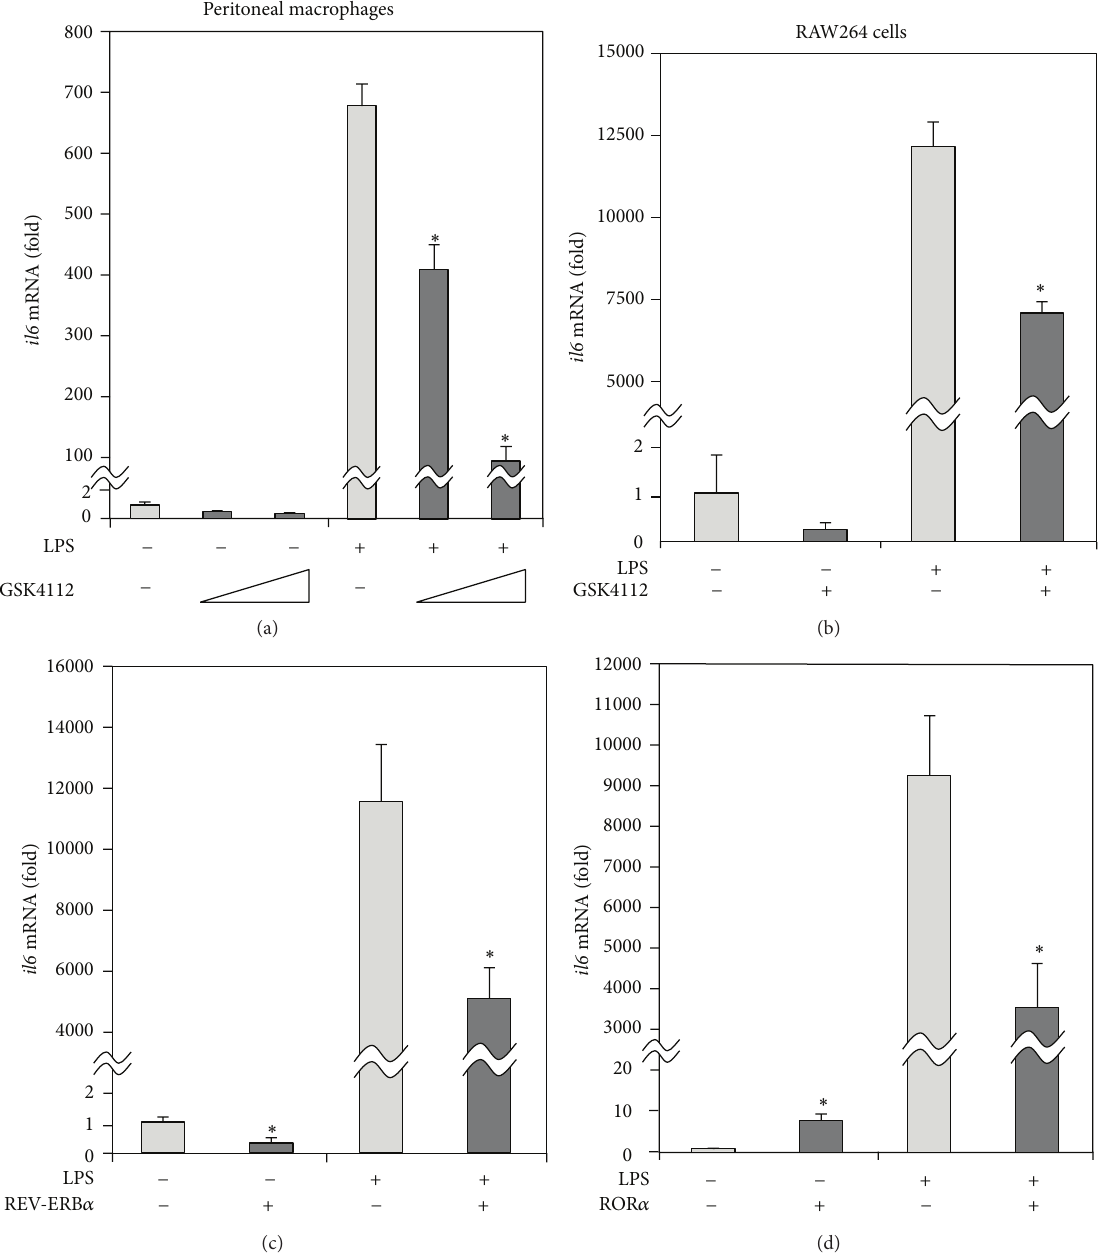
Figure 1: REV-ERB 𝛼 represses il6 gene induction following a LPS challenge in macrophages. (a) Peritoneal macrophages were harvested as adherent cells from 2-month-old C57BL/6J mice and were either untreated or treated with 1 𝜇 g/mL LPS or 2 or 20 𝜇 M GSK4112 for 16 h. (b) Murine macrophage cell line RAW264 cells were either untreated or treated with 1 𝜇 g/mL LPS or 20 𝜇 M GSK4112 for 16 h. (c) RAW264 cells transfected with or without rev-erb 𝛼 were either untreated or treated with 1 𝜇 g/mL LPS for 24h. (d) RAW264 cells transfected with or without ror 𝛼 were either untreated or treated with 1 𝜇 g/mL LPS for 24 h. The gene expression of il6 was analyzed by qPCR. For normalization, actb mRNA was used. The data are presented as the means ± S.E. ( 𝑛 = 3 - 4 ). ∗ 𝑃 < 0.05 versus cells treated with LPS and without GSK4112 or versus vector